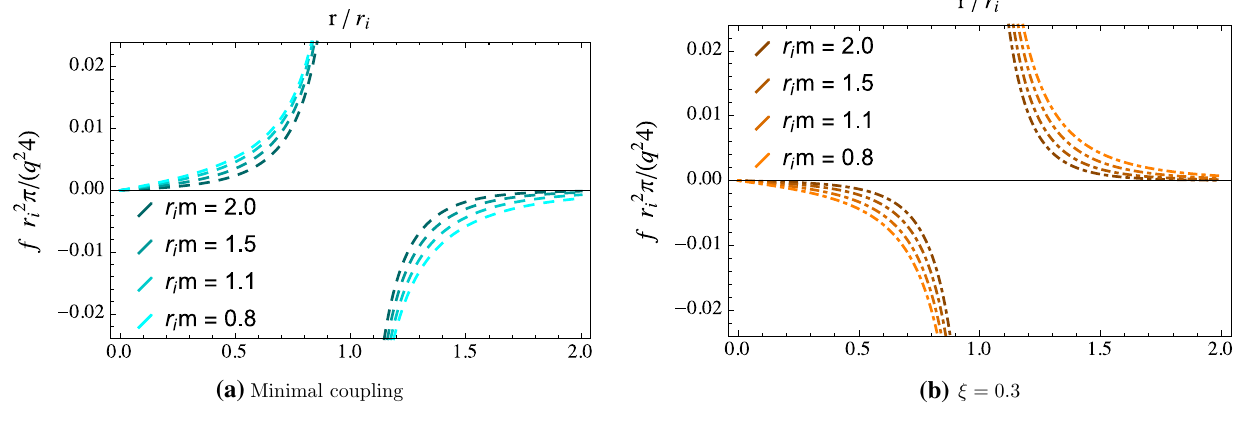
π r 2 i f as a function of r / r i in a Type I spacetime with κ < 0 ( ω i = 1, ω e = 0 . 9) and different values of r i m 4 q 2